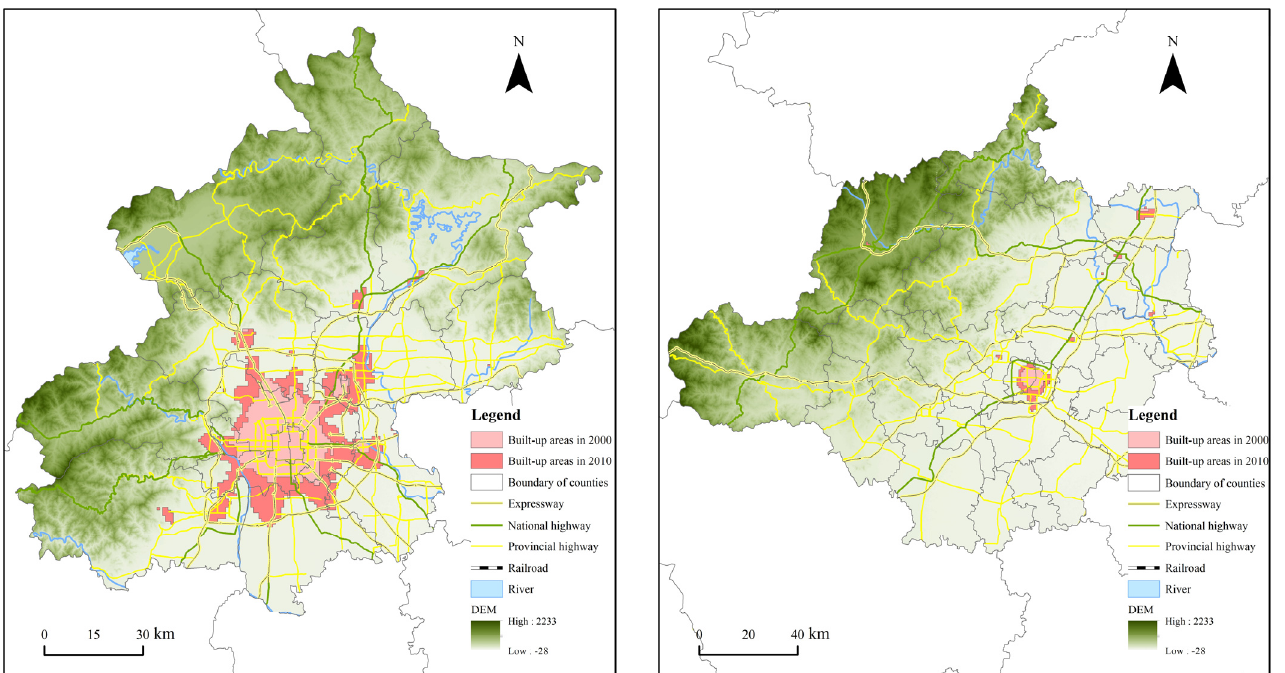
Figure 4. Spatial Expansion Patterns of Beijing and Baoding from 2000 to 2010.